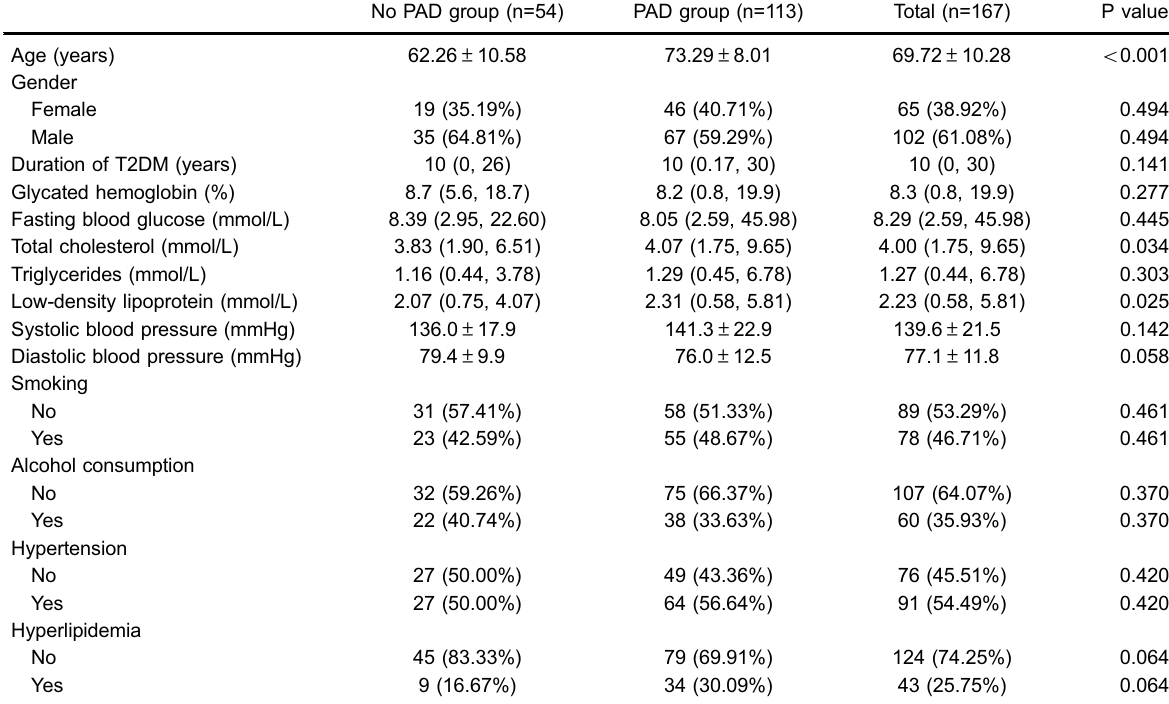
Table 1. Clinical characteristics of the study participants according to the presence or absence of peripheral arterial disease